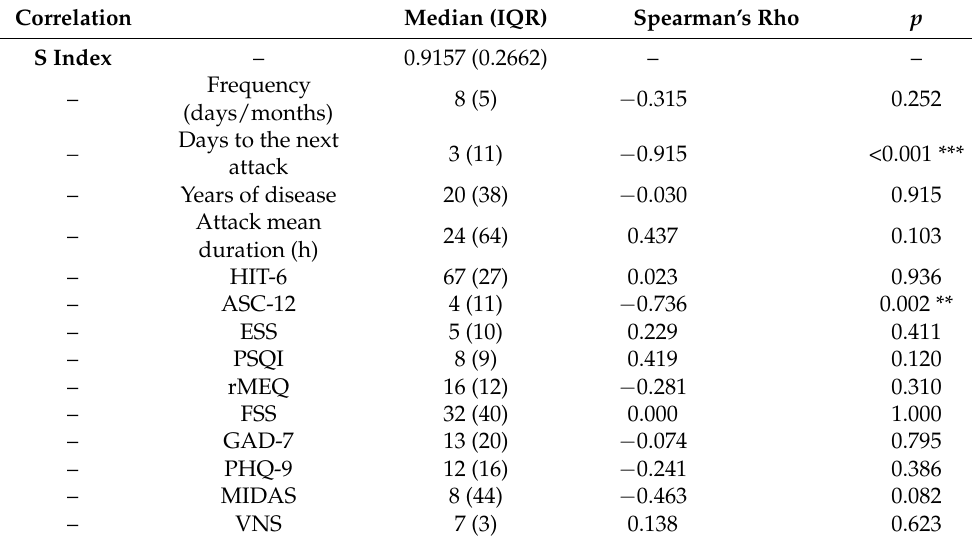
Table 3. Correlation of S index and clinical features of migraine patients at baseline (T0). Correlation